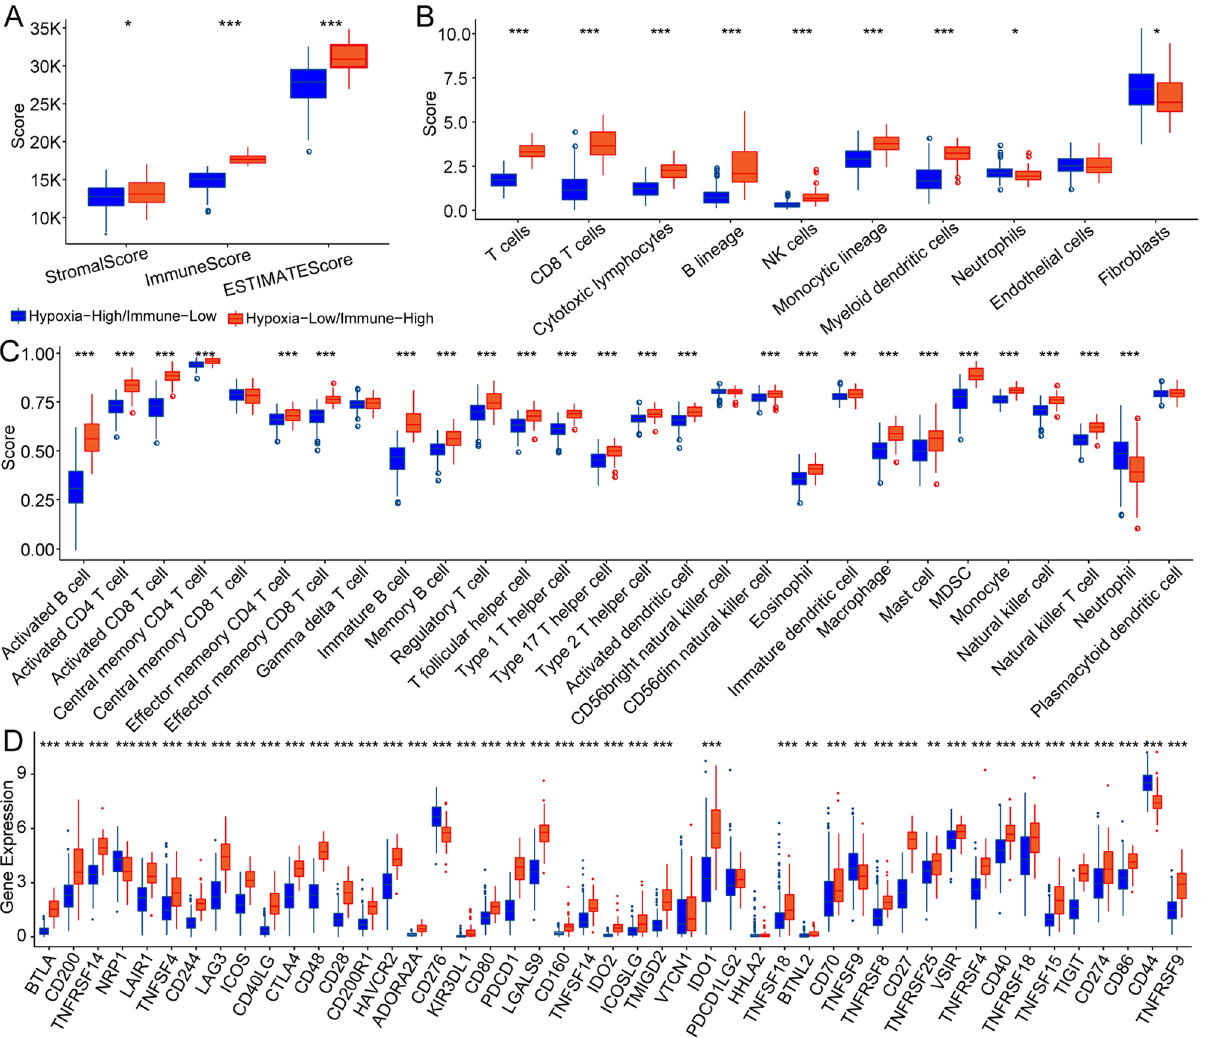
Figure 4. Immune microenvironment analysis and immune checkpoint analysis of hypoxia-immune groups. ( A ) Comparison of differences in immunological scores between different hypoxia-immune groups. ( B ) Comparison of differences in the MCP-counter immunity score between hypoxia-immune groups. ( C ) Comparison of ssGSEA immune score differences between hypoxia-immune groups. ( D ) Comparison of differences in immune checkpoints between hypoxia-immune groups. * p < 0.05, ** p < 0.01, *** p <